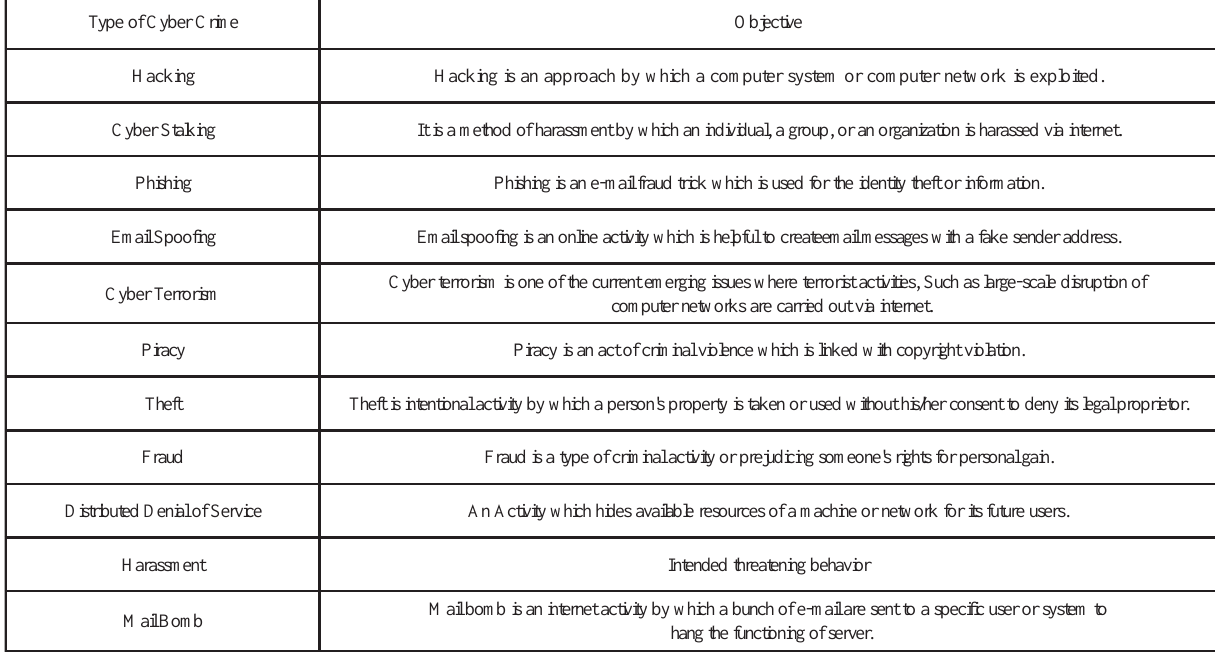
TABLE 2. TYPES OF CYBER CRIMES ALONG WITH THEIR OBJECTIVES